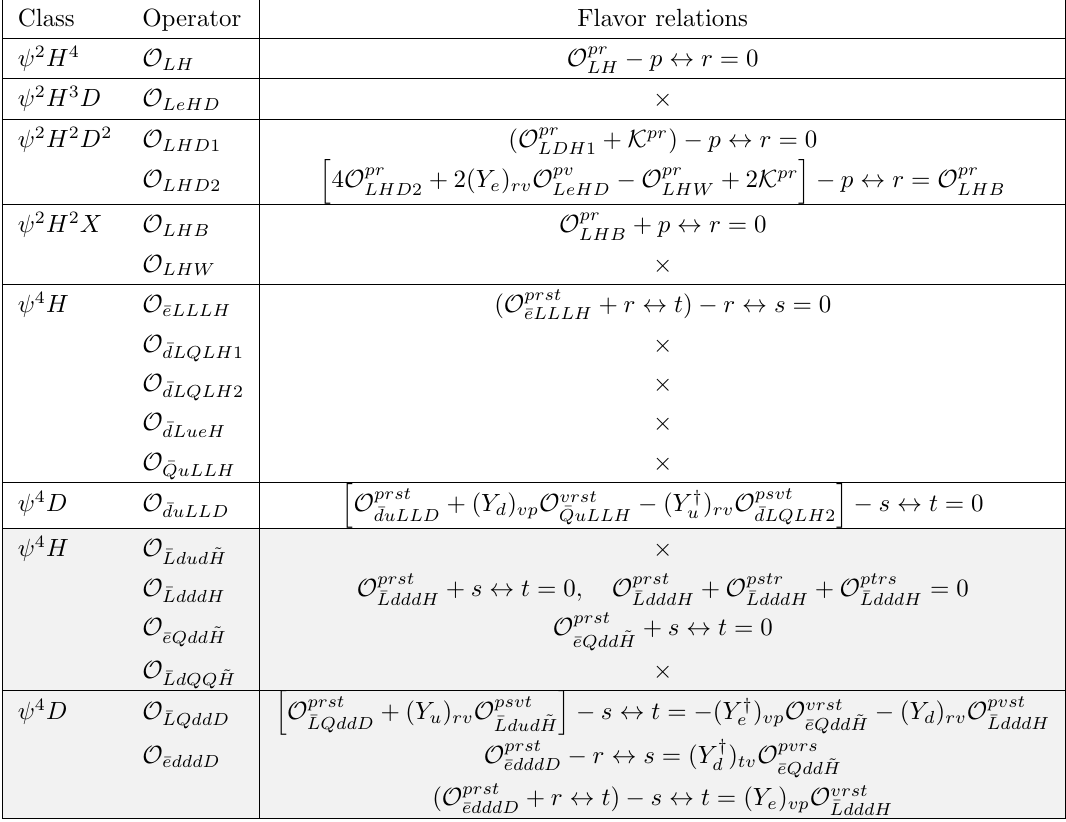
With three like-charge fermions the relations generally have a mixed symmetry, and these cover the operators O prst and O prst . Nontrivial (cid:13)avor relations exist for operators that (cid:22) LdddH (cid:22) eLLLH involve at least one derivative, including O pr , O pr , O prst , O prst , and O prst . (cid:22) duLLD (cid:22) LQddD LHD 1 LHD 2 (cid:22) edddD This explains why this feature appears (cid:12)rst at dimension seven but not lower dimensions, and it is expected to prevail at higher dimensions. We list all (cid:13)avor relations in table 2, in which a shortcut is used,